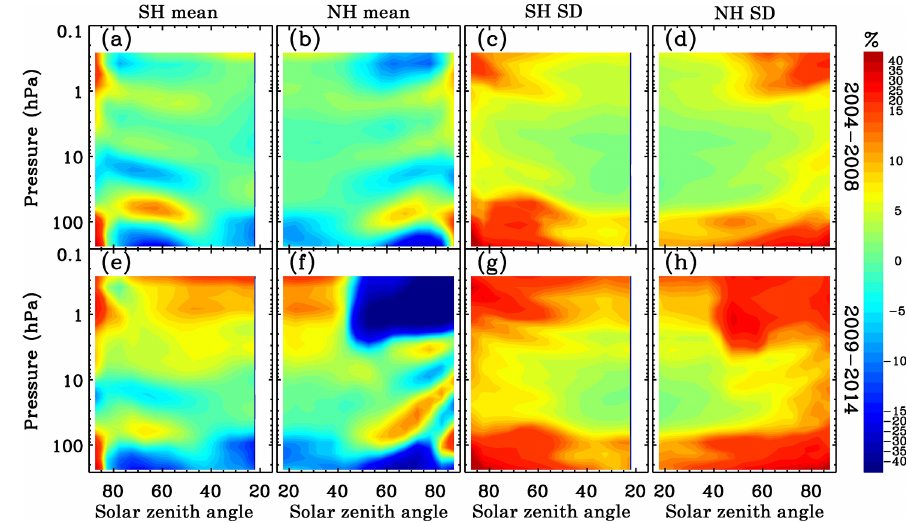
Figure 6. Similar to Fig. 5 but as a function of solar zenith angles for Southern and Northern